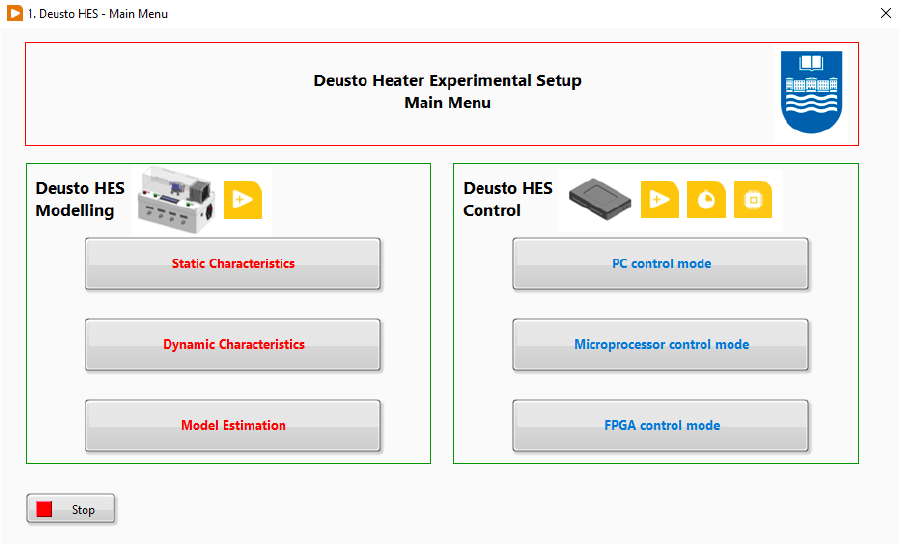
Figure 16. Main menu of the LabVIEW-based application to operate with Deusto HES prototype. Deusto HES